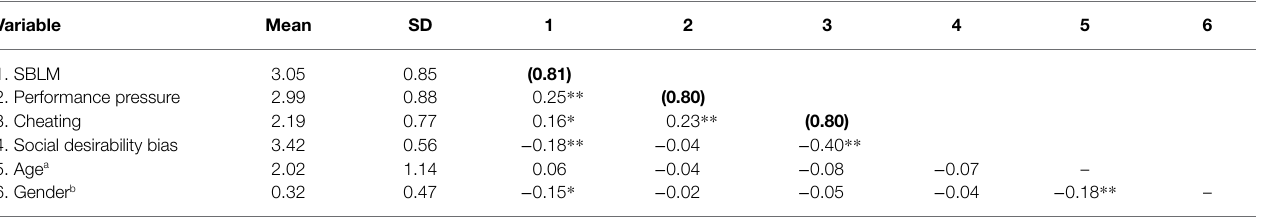
TABLE 3 | Descriptive statistics, correlations and AVE Values (Study 1).